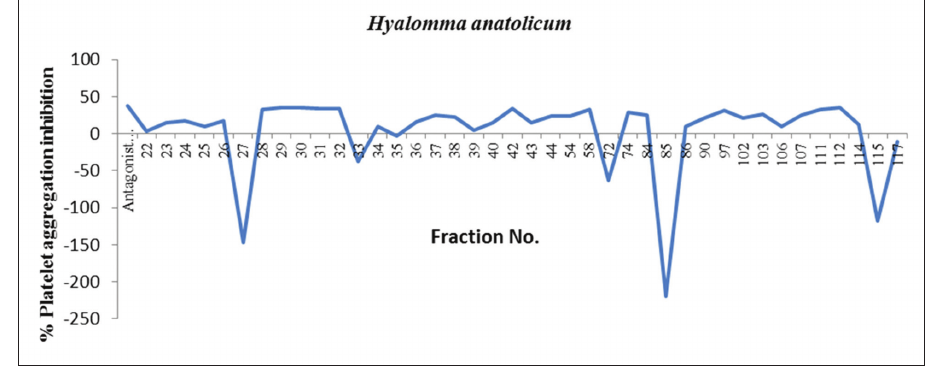
Figure-3: Percent platelet aggregation inhibition by Hyalomma anatolicum salivary gland protein